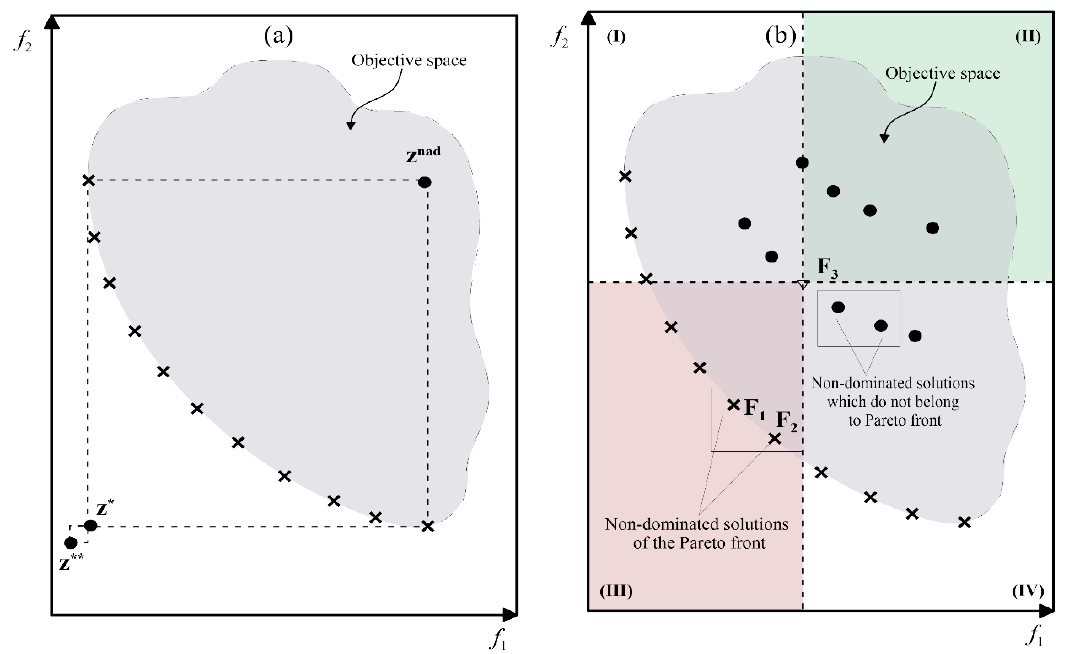
Figure 6. Description of the objective space of the MOP. ( a ) Objective space and Pareto front; ( b ) division of objective space according to dominance relationships, (I) and (IV) regions with non- dominated solutions that do not dominate by OF 3 , (II) region of solutions dominated by OF 3 , (III) solutions that dominate OF 3 .